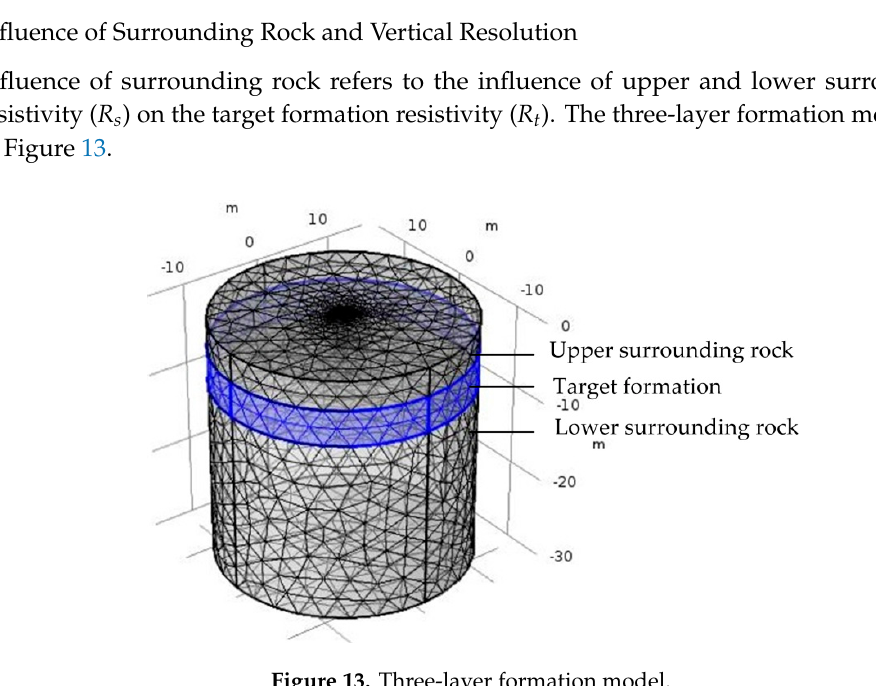
Figure 12. Detection depth and invasion radius.